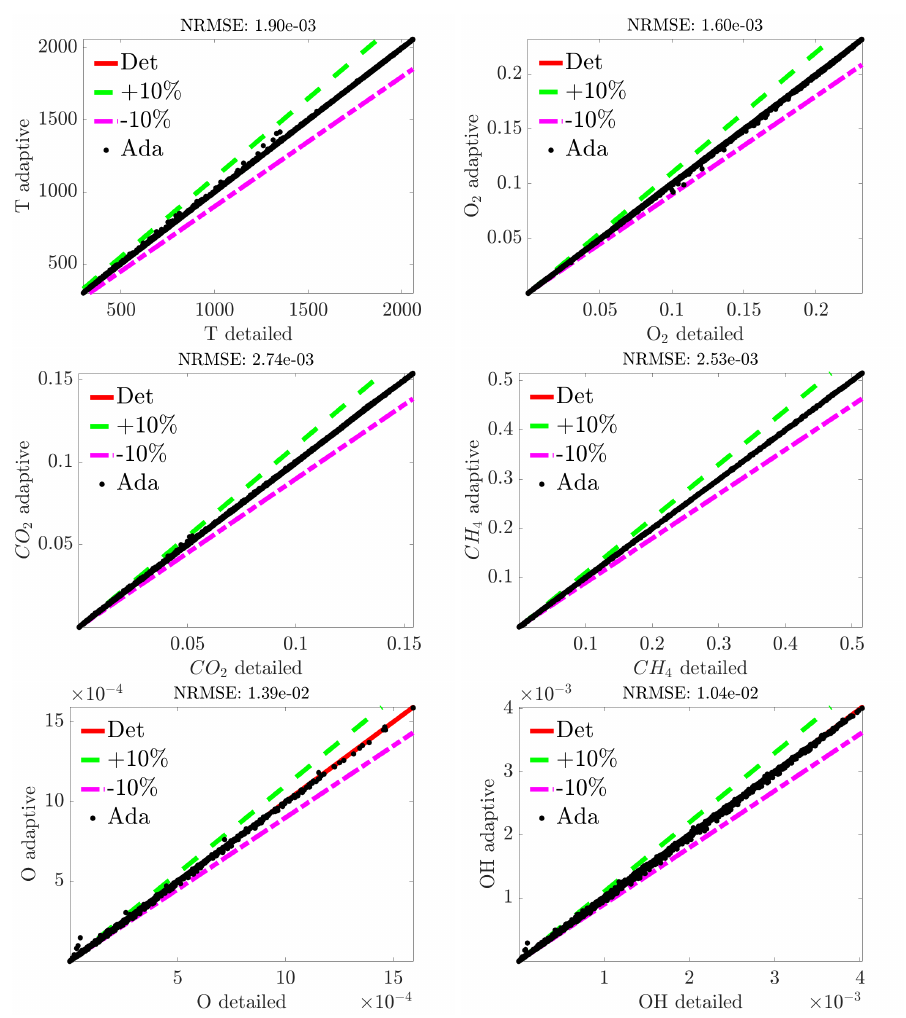
Figure 4. Parity plots of temperature and selected species at t = 0.03 s for the adaptive-chemistry unsteady simulation of a 2D laminar flame with reduced mechanisms generated from the SKM clustering approach, ( (cid:101) DRGEP = 0.005), auto scaling criterion.